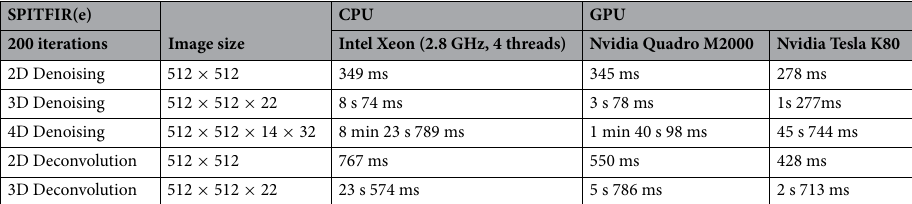
Table 3. Computing times of SPITFIR(e) (200 iterations for energy